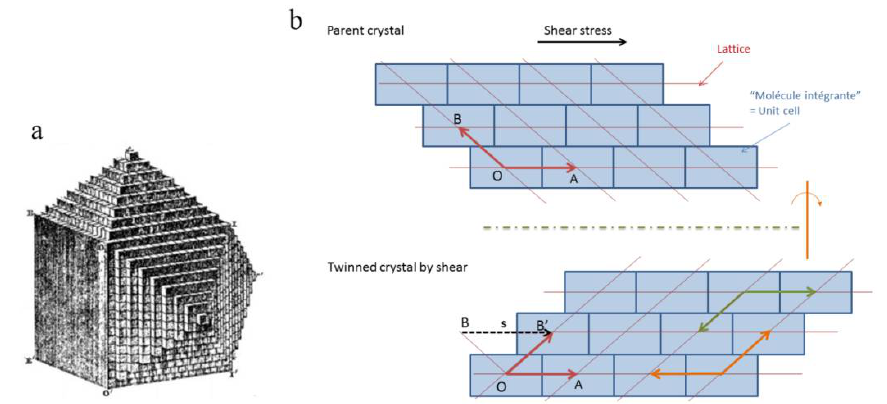
Figure 1. Crystal and deformation twinning. ( a ) Crystal imagined as a stacking of bricks called “ molecules intégrantes ”, as published in 1801 by Haüy [7], and nowadays called a “unit cell” or “motif”; ( b ) The way to envision deformation twinning at the end of the 19th century was probably as follows: twinning can be obtained by bricks gliding on themselves in such a way that the lattice is restored after the glide. The basis vectors are represented by the red arrows, they are modified by the shear, but the newly formed red twinned lattice is equivalent to the initial one by a reflection or by a 180° rotation.